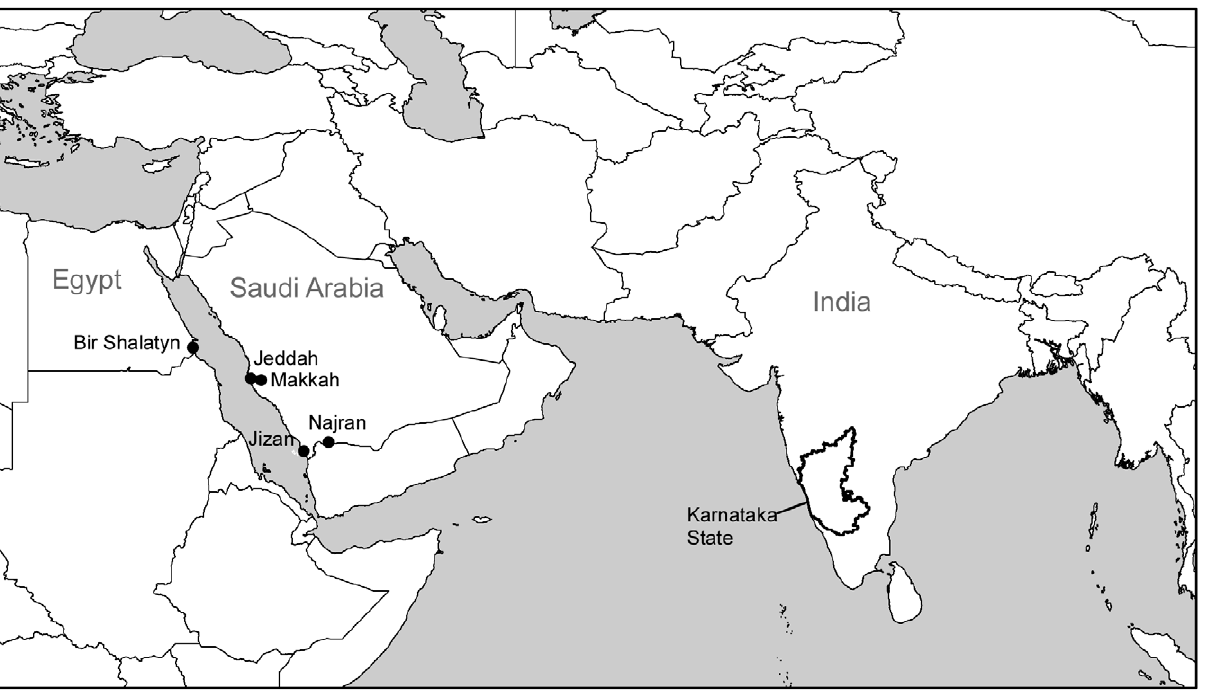
Figure 1. Map of regions where AHFV or KFDV have been isolated. AHFV cases have been documented in southern and western Saudi Arabia (Jizan/Najran and Jeddah/Makkah), and most recently at the Egypt-Sudan border (Bir Shalatyn or Shalatin). KFDV cases have been confined to Karnataka State, India (outlined).